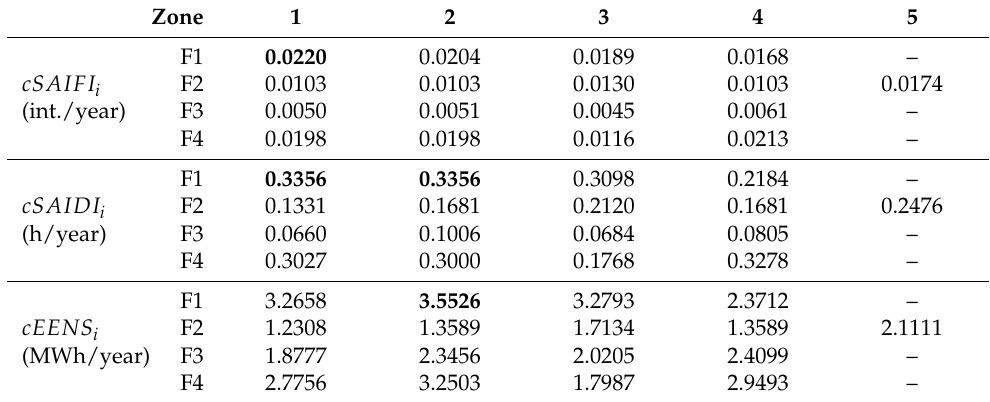
Table 7. Contribution of faults in zones to the reliability indices obtained using the correlated